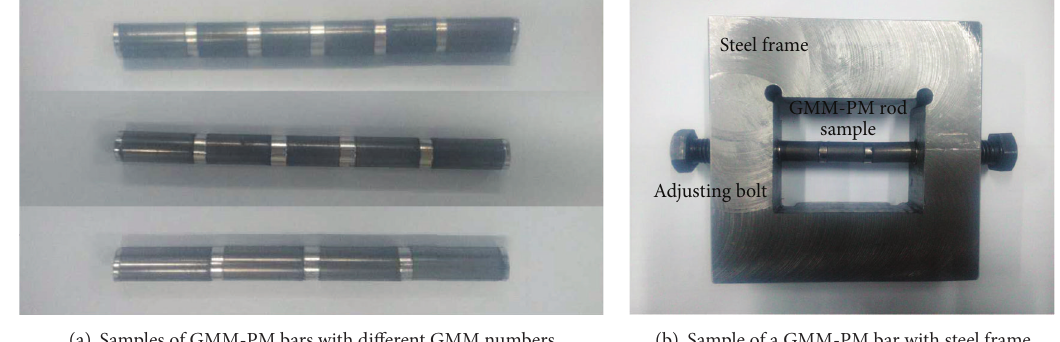
Figure 15: Samples of GMM-PM bars for magnetic field intensity tests.